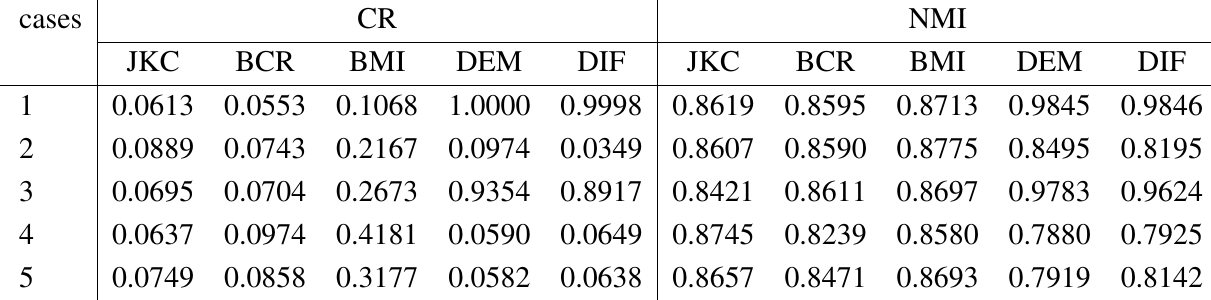
Table 1. CR and NMI values for different registration methods (The smaller values usually mean the better registration